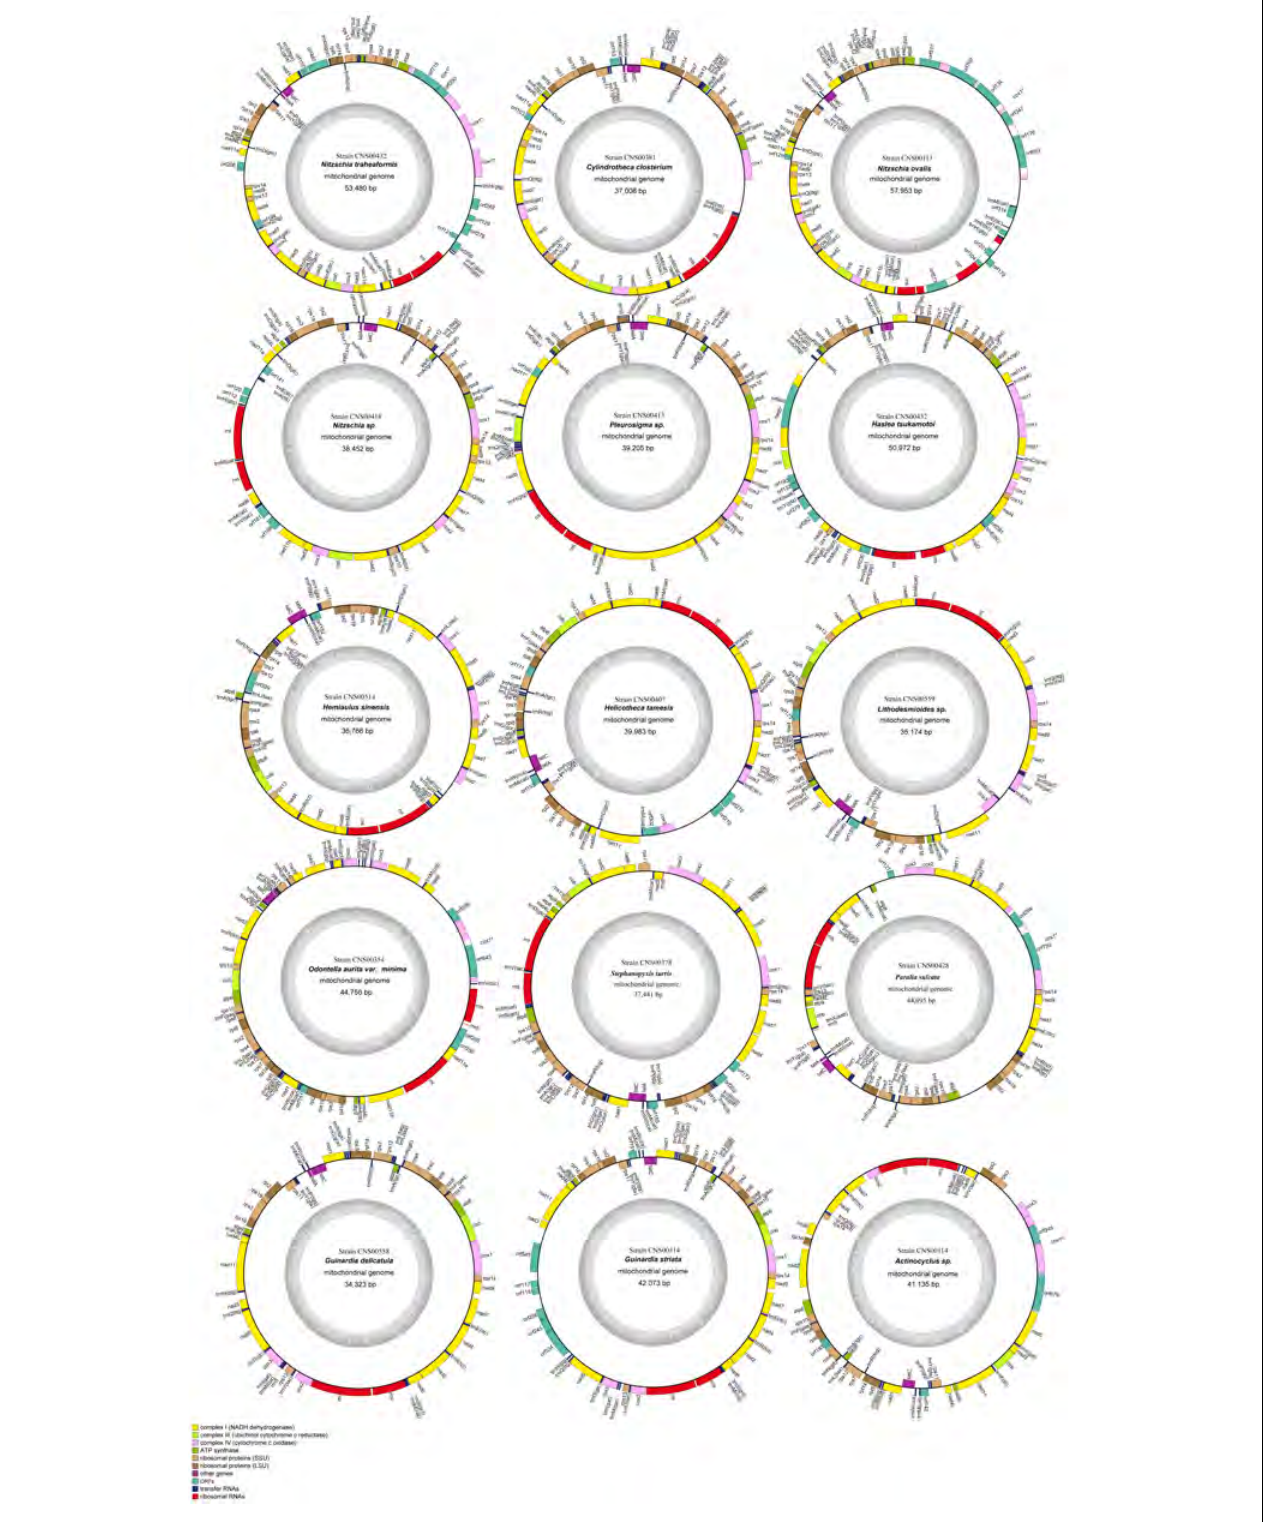
FIGURE 3 | Circular maps of 15 complete mtDNAs. Genes shown on the inside of the map are transcribed in a clockwise direction, whereas those on the outside of the map are transcribed counterclockwise. The assignment of genes into different functional groups is indicated by colors. The ring of bar graphs on the inner circle shows the AT content in light